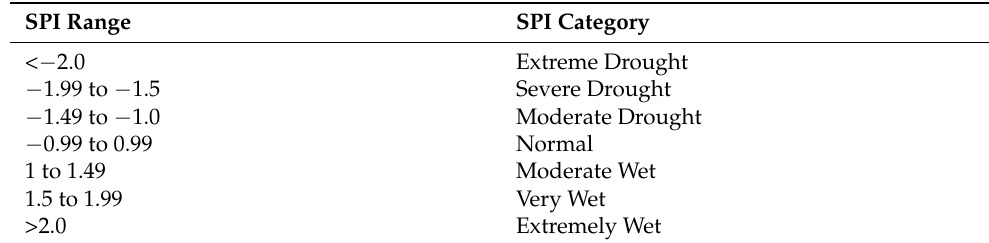
Table 2. Standard Precipitation Index (SPI)